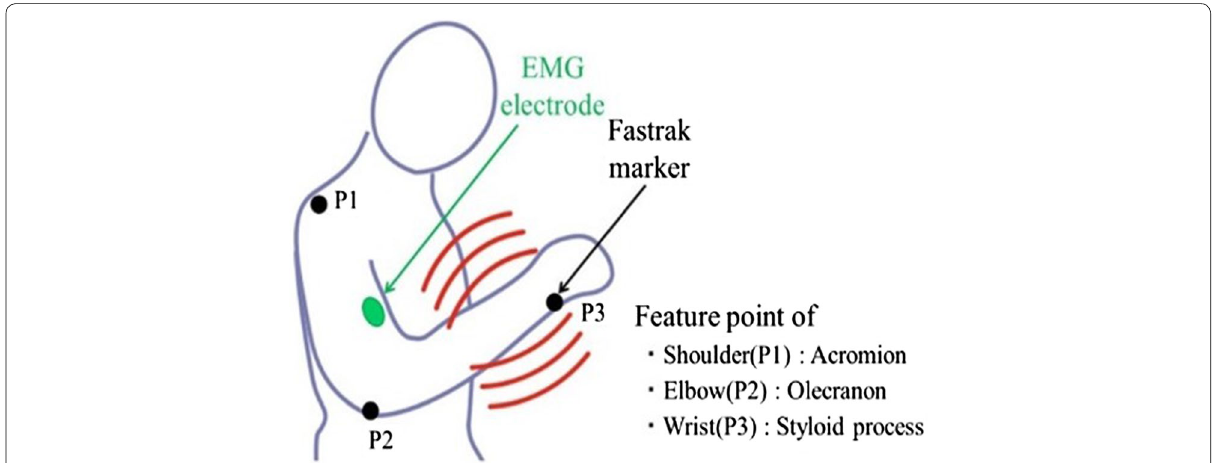
Fig. 11 Positions of EMG electrode and FASTRAK ®